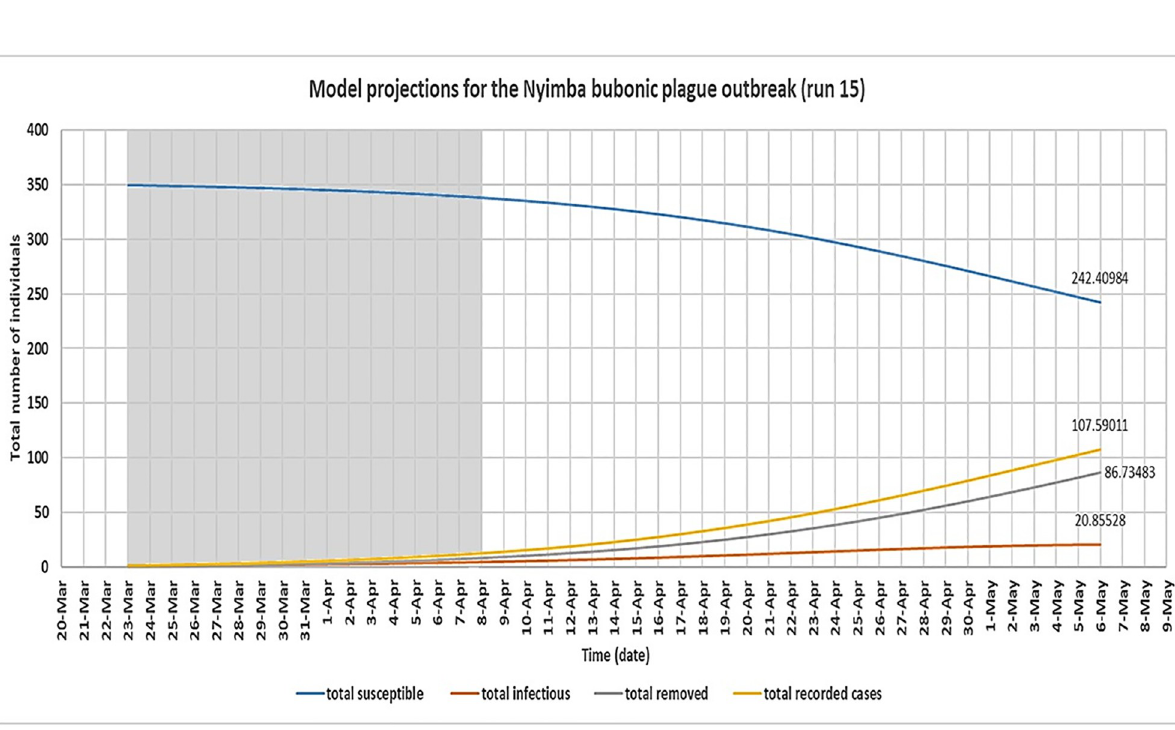
Fig 8. Derived SIR model simulation showing the model predicted most likely progression of the Nyimba bubonic plague outbreak for the different infection states of individuals for run 15 of the model simulation assuming no intervention was provided. (model simulation over a 45-day period.